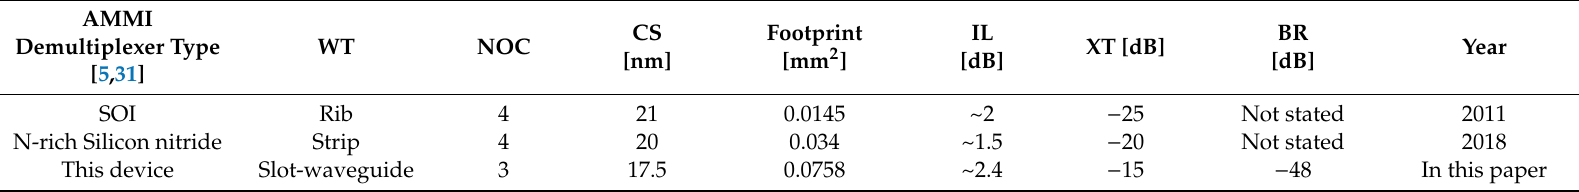
Table 5. Comparison between key characteristics of various AMMI demultiplexer types. SOI, silicon on insulator; WT, waveguide technology; NOC, number